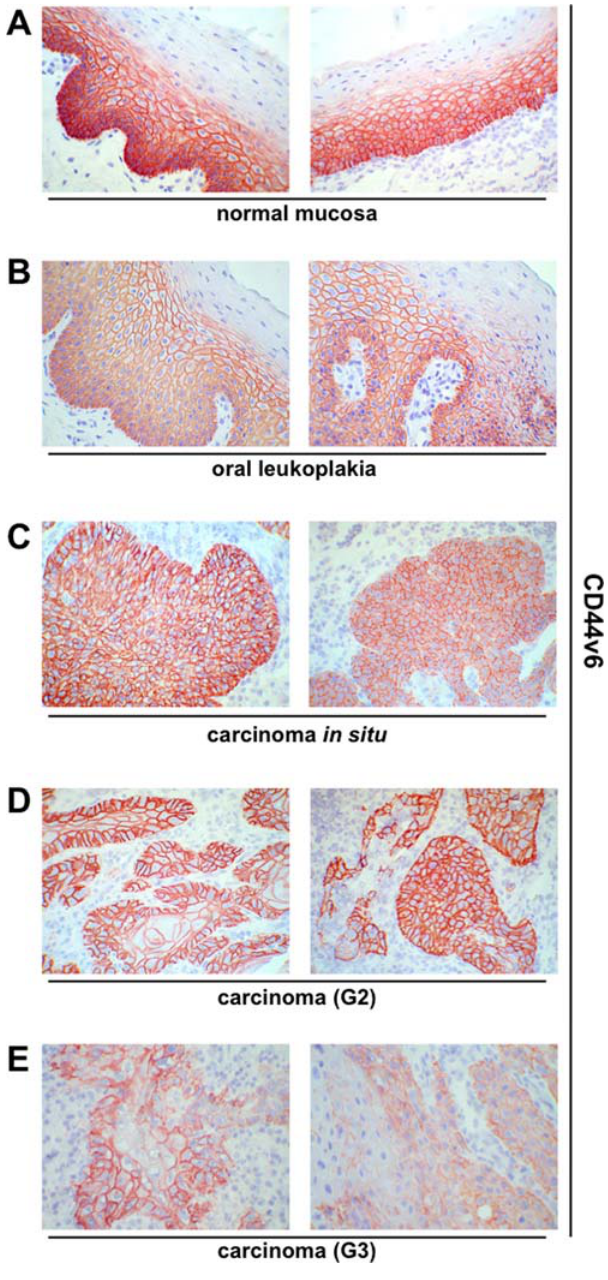
Figure 2. CD44v6 expression pattern in head and neck epithelia. CD44 splice variant 6 was visualised upon immunohisto- chemistry (reddish brown) in normal epithelium ( A ), oral leukoplakia ( B ), carcinomas in situ ( C ), grade 2 carcinomas ( D ), and grade 3 carcinomas ( E ). Cell nuclei are stained with hematoxylin (blue). Shown are representative